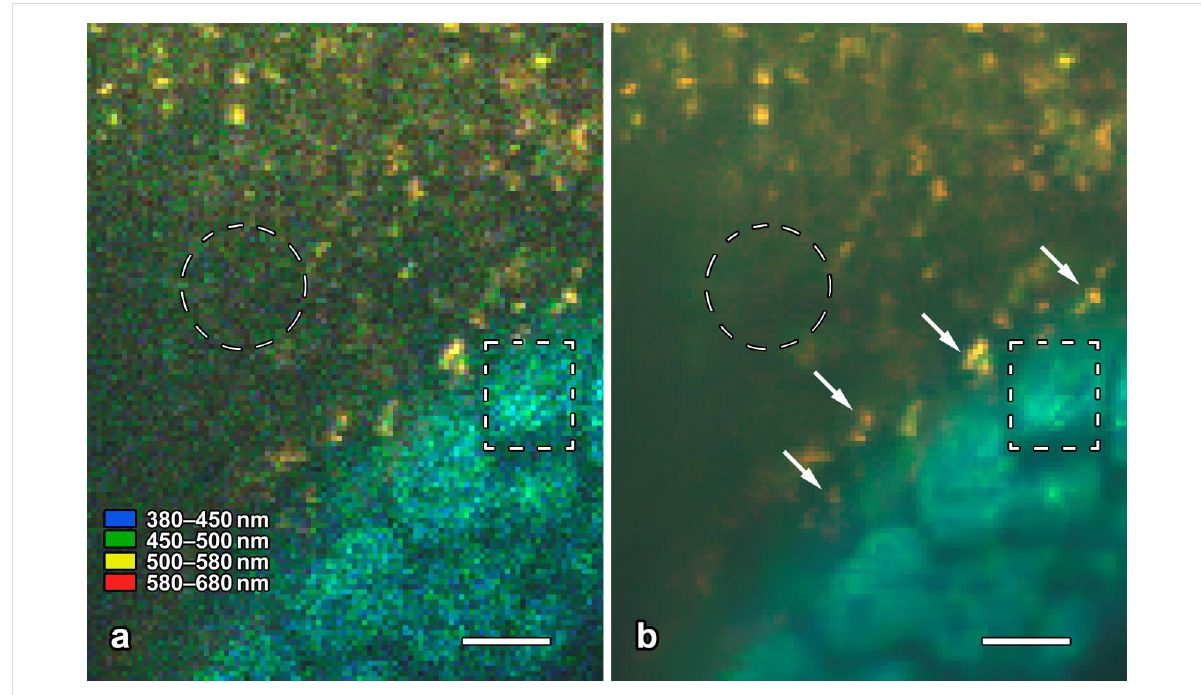
Figure 8: Intravital 2-photon microscopy of the gut mucosa (lower right corner) and quantum dot nanoparticles (yellow). Some of the nanoparticles adhere to mucus (upper third in a and b), some others adhere to the apical membrane of the epithelial cells (arrows in b). The grainy structure in the lumen (encircled in a) represents photon shot noise only; it is completely removed by the modified BM3D algorithm (b). In contrast, the structure of densely packed mitochondria is preserved in regions where the optical section runs through the apical cytoplasm of the cells (rectangle in b). Bar = 5 µm. The display colors selected for the 4 spectral channels are listed in a and almost meet the native color perception of the human eye.